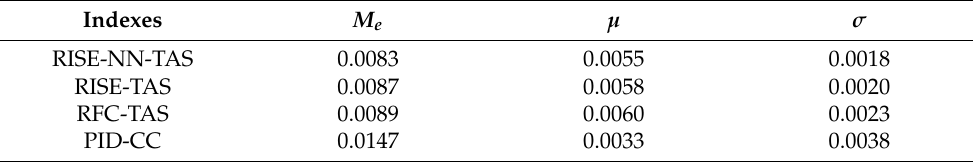
Table 3. Synchronization performance indexes of the four controllers in case